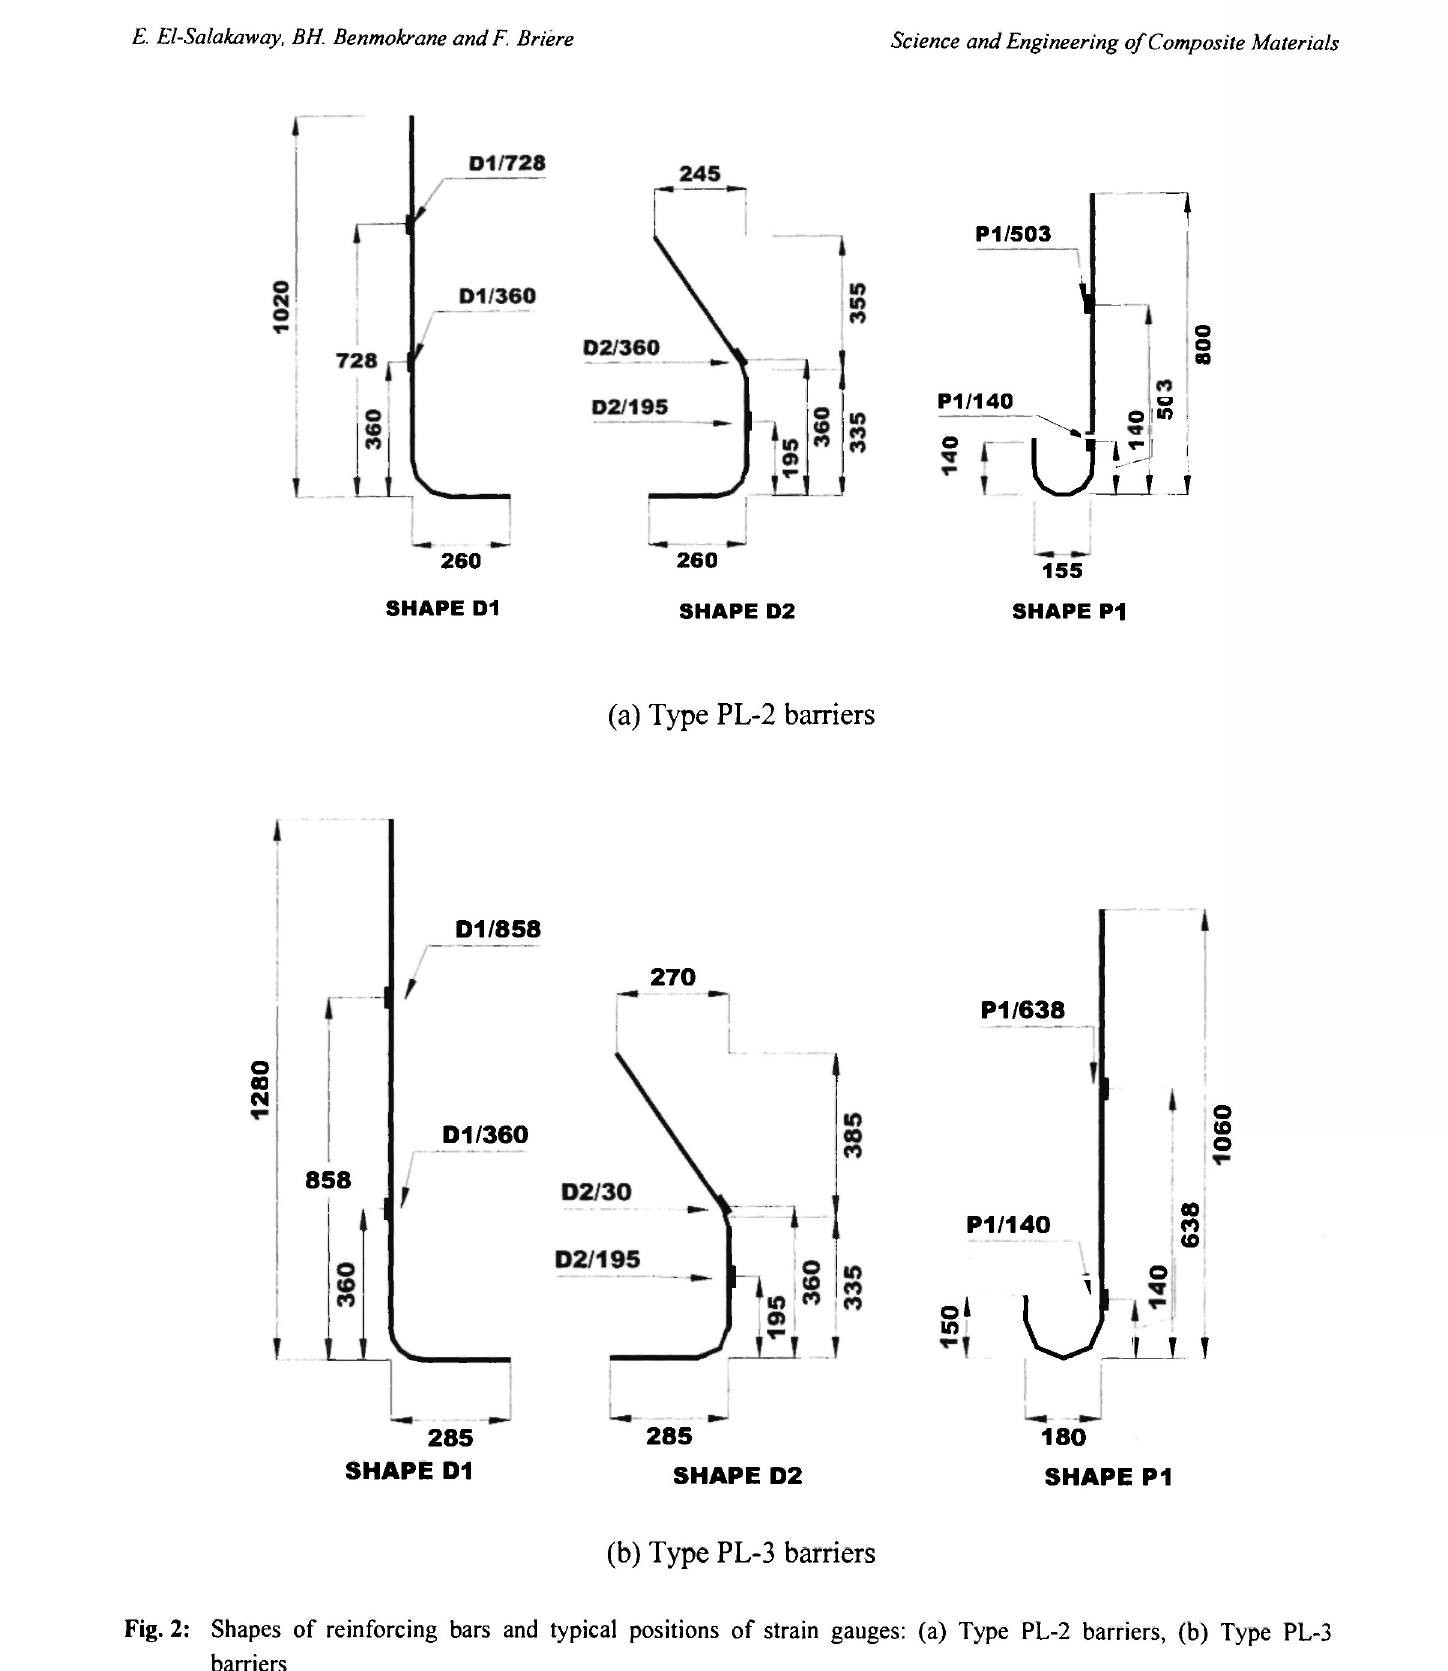
Fig. 2: Shapes of reinforcing bars and typical positions of strain gauges: (a) Type PL-2 barriers, (b) Type PL-3 barriers